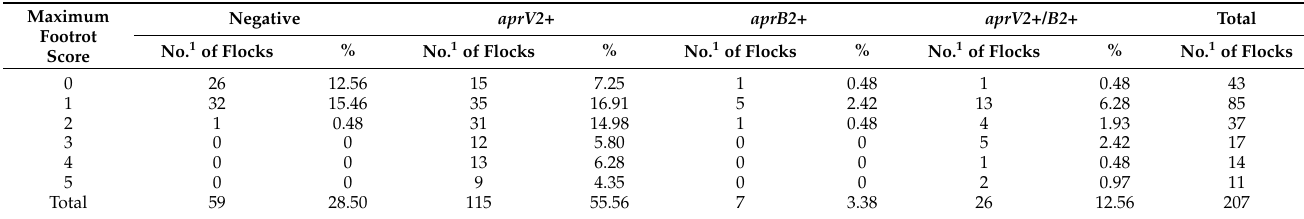
Table 7. Joint distribution of maximum Footrot Scores and qPCR results on flock